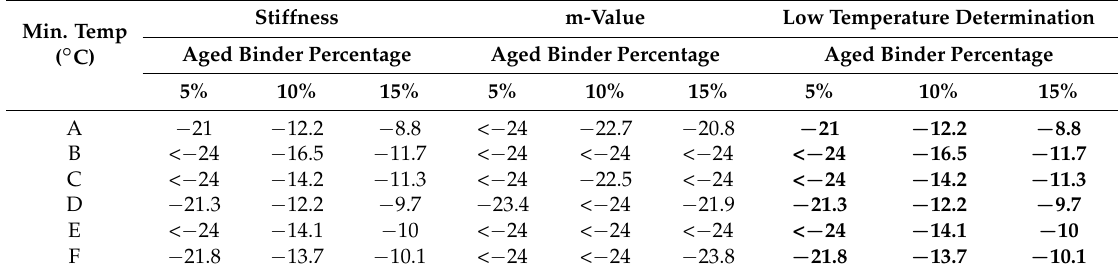
Table 2. Minimum low temperatures of RAP sources A–F with virgin binder PG 58-28.